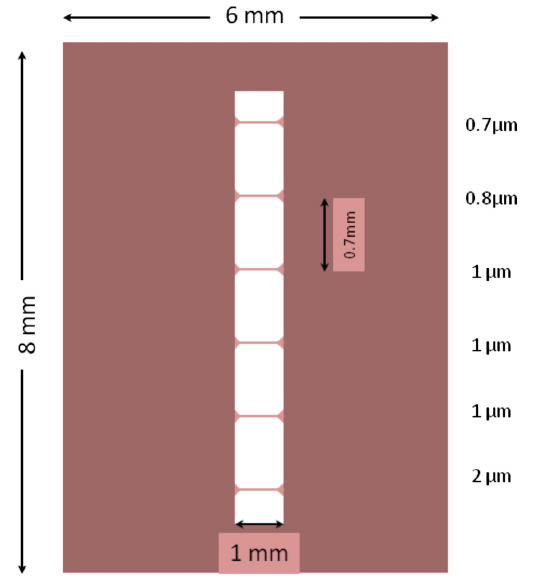
FIG. 3. Schematic drawing of the FERMI free-standing WS chip with indication of the width of the free-standing stripes allocated on